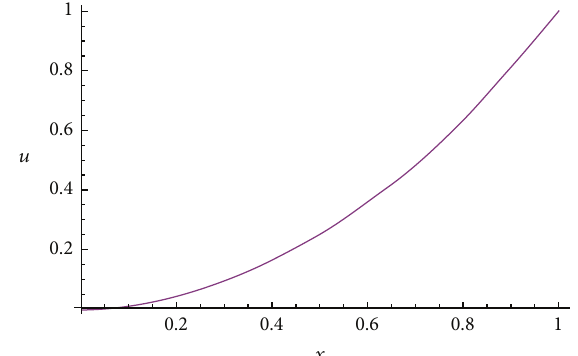
Figure 3: Plots of the approximate solution and the exact solution for